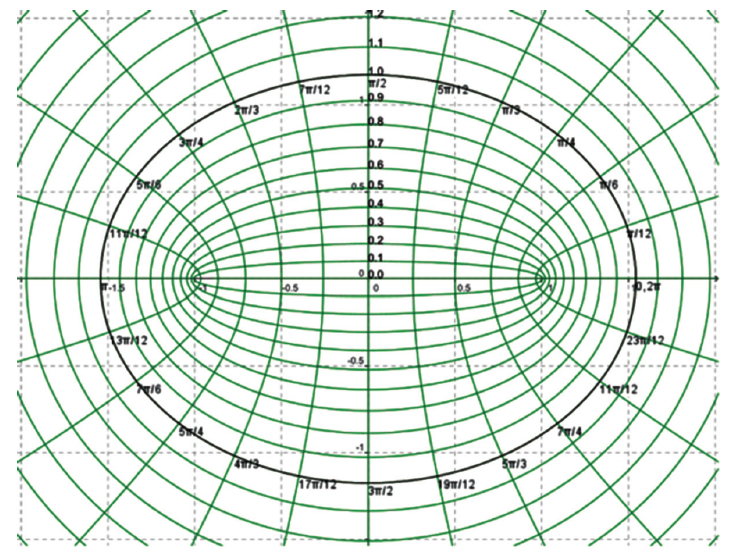
Fig. 2. The conical coordinates grid on the plane